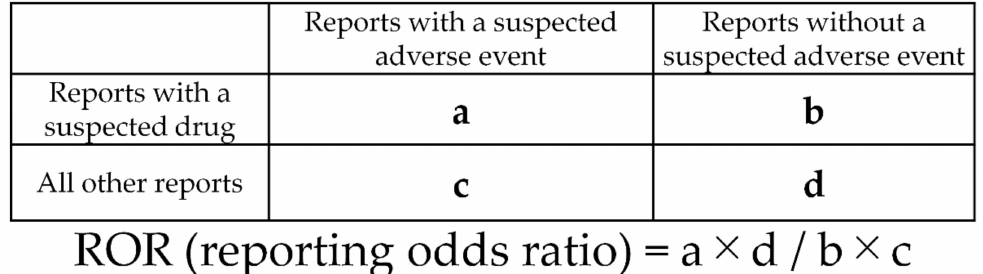
Figure 4. Cross-tabulation and formula used to calculate the ROR for an adverse event. The cross- tabulation is structured with reports for the suspected drug, all other reports, reports with an adverse event, and reports without an adverse event (a–d indicate the number of reports). This study shows the reporting odds ratio (ROR) as the odds ratio